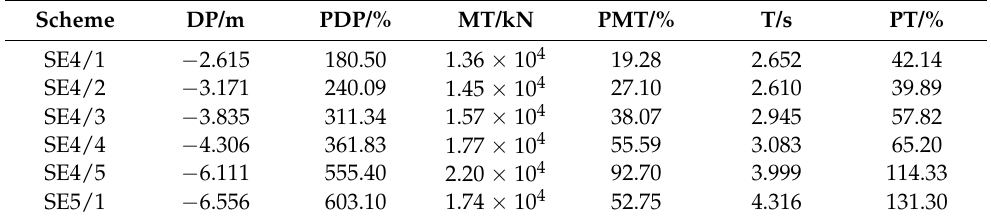
Table 6. Results of deleting four or five virtual rings.